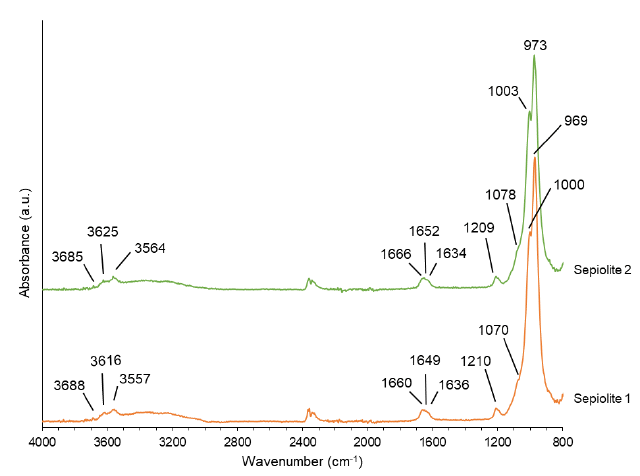
Figure 3. FTIR spectra of the sepiolite samples.